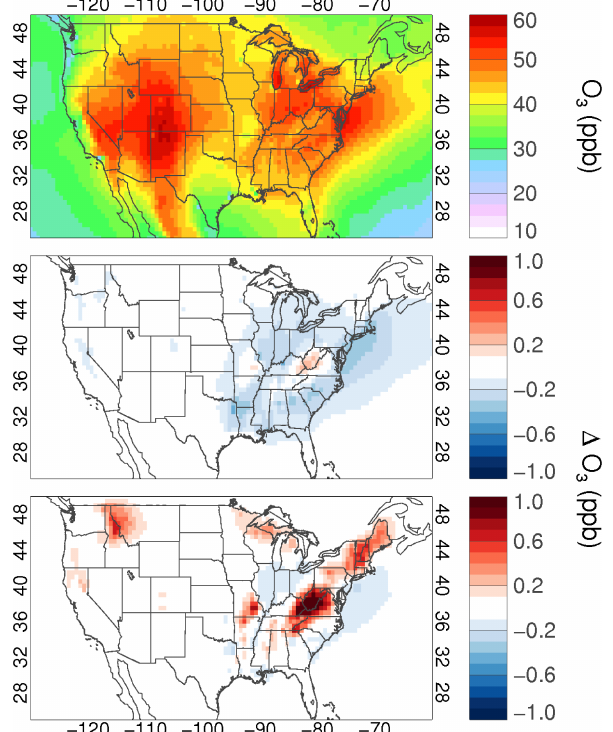
Figure 6. Top: mean JJA surface O 3 concentrations in the base sim- ulation (Simulation 1). Middle: the change in O 3 concentrations resulting from mortality-driven changes in emissions only (Simu- lation 3 – Simulation 1). Bottom: the change in O 3 concentrations resulting from mortality-driven changes in emissions and deposition velocity together (Simulation 4 – Simulation 1).